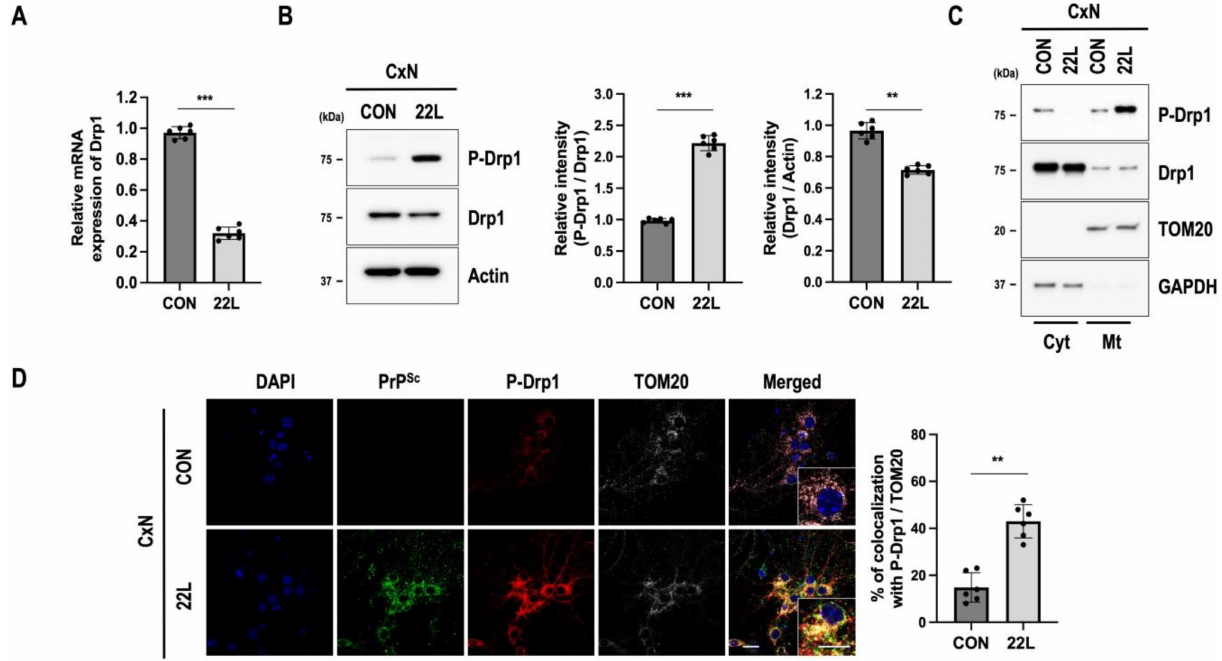
Figure 2. Scrapie infection induces phosphorylation of Drp1 at Ser616 (P-Drp1), which colocalizes with PrP Sc in the mitochondria. ( A ) The mRNA level of Drp1 was analyzed using qRT-PCR ( n = 6, *** p < 0.001; two-sided Student’s t -test). ( B ) Phosphorylation of Drp1 at Ser616 (P-Drp1) in control (CON) or 22L scrapie-infected (22L) CxN cells at 21 dpi was examined by Western blotting. The intensities of the bands were measured and quantified for each group ( n = 6, *** p < 0.001, ** p < 0.01; two-sided Student’s t -test). ( C ) Drp1 and P-Drp1 levels in the cytosolic (Cyt) and mitochondrial (Mt) fractions. TOM20 and GAPDH were used as markers of the mitochondrial and cytosolic fractions, respectively. ( D ) The triple-localization of PrP Sc (green) with P-Drp1 (red) and TOM20 (white) was determined using confocal microscopy. Quantification of mitochondrial fission by P-Drp1 and TOM20 and mitochondrial translocation was analyzed using EzColocalization plugin for ImageJ software version 1.53a ( n = 6, ** p < 0.01; two-sided Student’s t -test). DAPI (blue) was used to counterstain the nuclei; n = number of independent experiments. Enlarged insets (white line boxes) showed the sections at a higher magnification, scale bar, 20 µ m. Bullets in bar graph represent datasets from independent